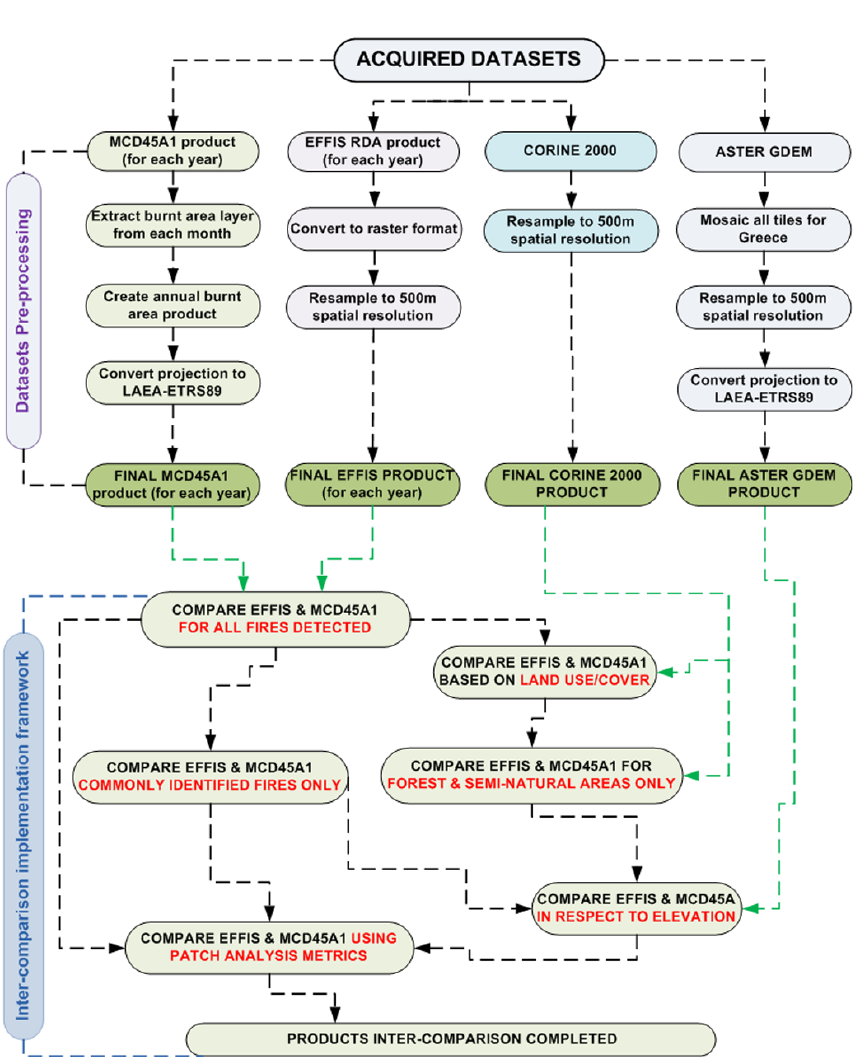
Fig. 1. Overview of the methodology implemented in the present study, in terms of both data pre-processing and their